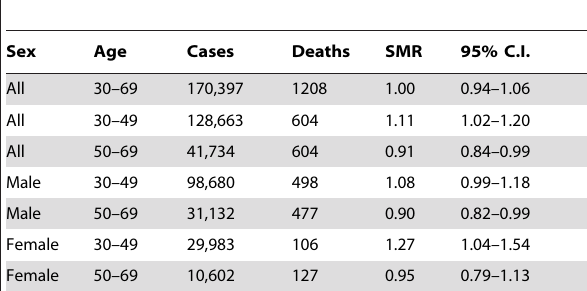
Table 8. Traditional approach for the entire 13-year observation period.